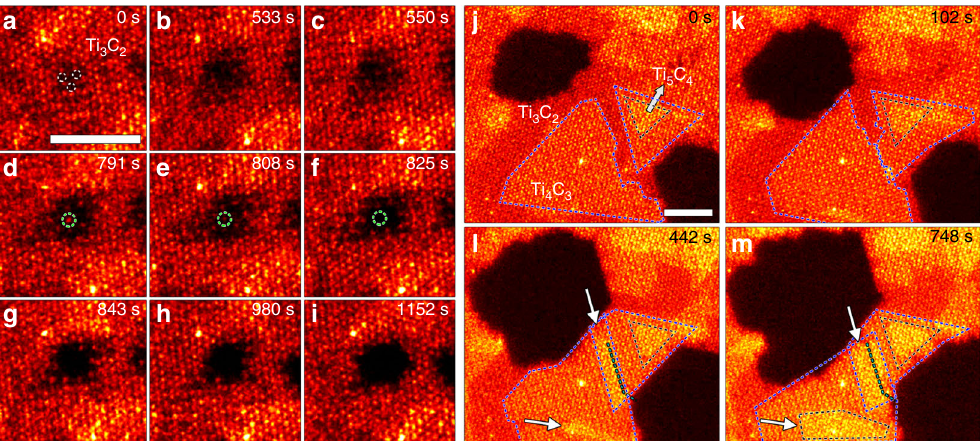
Fig. 2 Dynamic growth process as revealed by atomic resolution STEM imaging. a – i Pore expansion captured by a series of time-lapsed STEM images acquired from a monolayer Ti 3 C 2 area following electron-beam irradiation and heating at 500 °C. The initial 3-V Ti cluster is indicated by three white dotted circles. The last Ti atom that migrates to the surface before pore formation is indicated by the green dotted circle. j – m Time-lapsed STEM images showing the dynamic expansion of island growth of h -TiC adlayers (Ti 4 C 3 : blue dotted lines, Ti 5 C 4 : black dotted lines) on Ti 3 C 2 substrate at 500 °C. White arrows in l and m indicate overlap of h -TiC adlayers on bottom and up surfaces to form Ti 5 C 4 . Cyan dashed lines in l and m indicate the projected grain boundary where the two adlayers fi rst encounter in k . The scale bars are 2